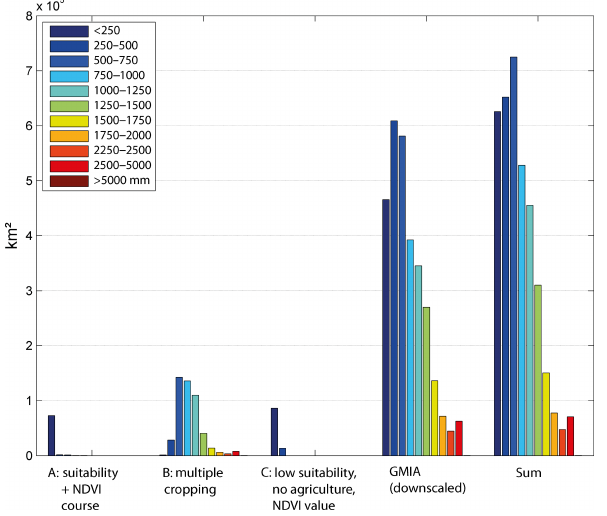
Figure 6. Yearly precipitation within the irrigated areas. Criteria A and C are suitable in dry regions, while criterion B identifies in hu- mid regions as well. Further, irrigation decreases with increasing precipitation, but is also used in regions with high yearly precipita- tion.